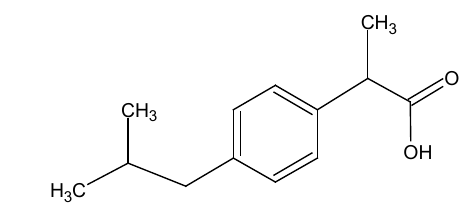
Figure 1. Ibuprofen (2-(4- isobutylphenyl)propionic acid)